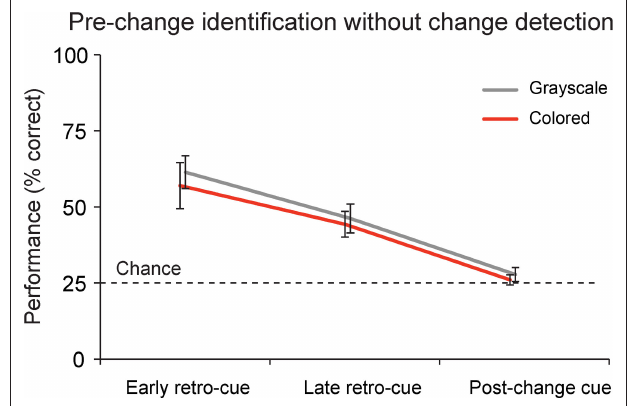
Figure 3 | identification without change detection. On a proportion of the change trials, subjects were not able to detect the change, but did identify the item that was present in the memory display, but not anymore in the test display. This proportion was about 54% in the early retro-cue conditions, 42% in the late retro-cue conditions and 26% in the post-change cue conditions. Data are depicted as the mean ± the standard error of the